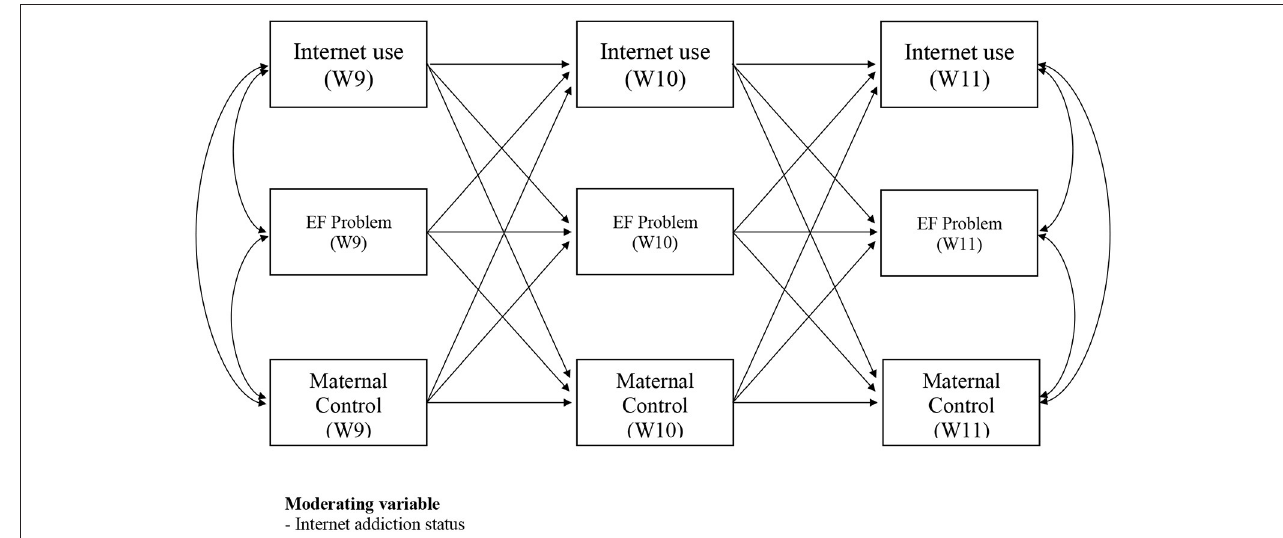
FIGURE 1 | Hypothetical model ( N = 1,463). EF, Executive